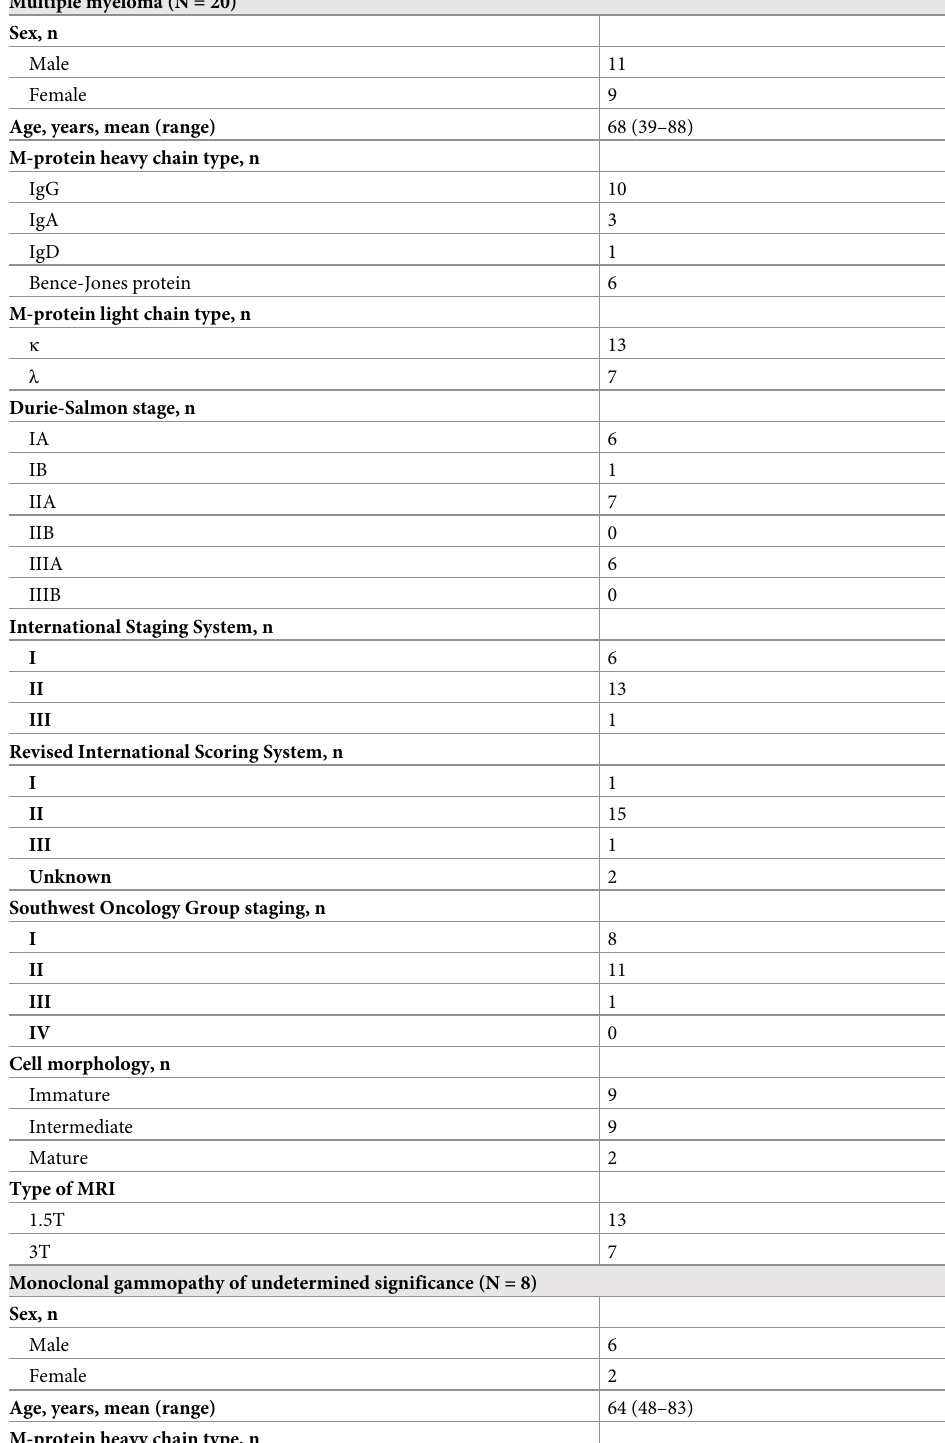
Table 1. Demographic and clinical characteristics of patients with newly diagnosed multiple myeloma and mono- clonal gammopathy of undetermined